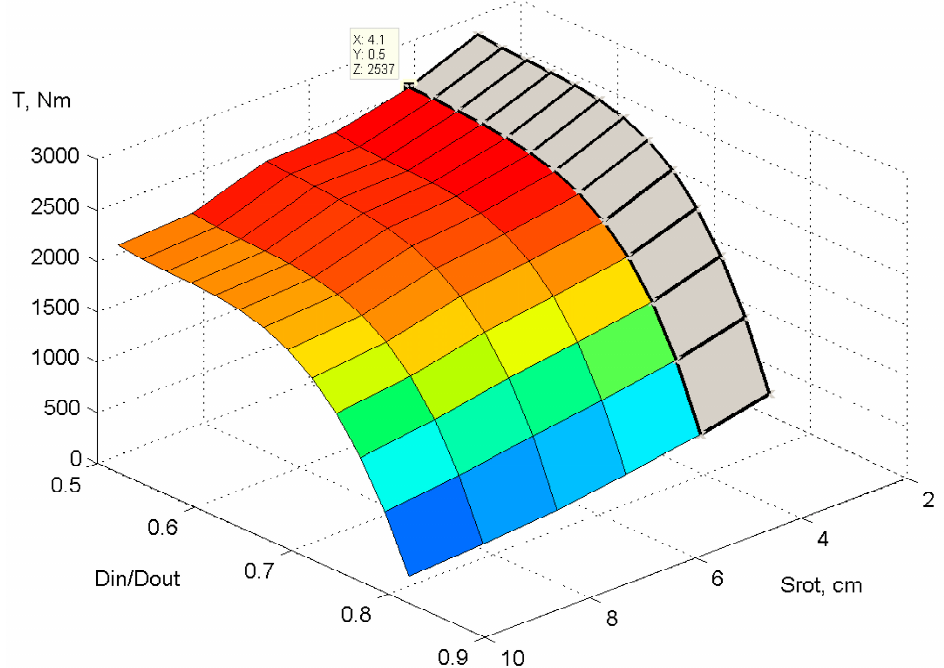
Figure 6. The surface of optimization of weight and dimensions of the machine.